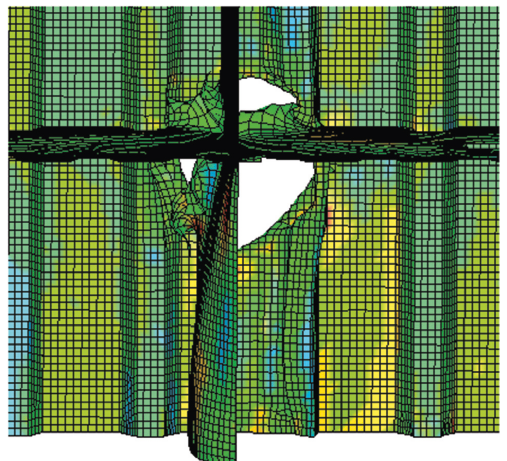
Figure 16: Final damage shape of explosion in position 4 (time unit: ms).